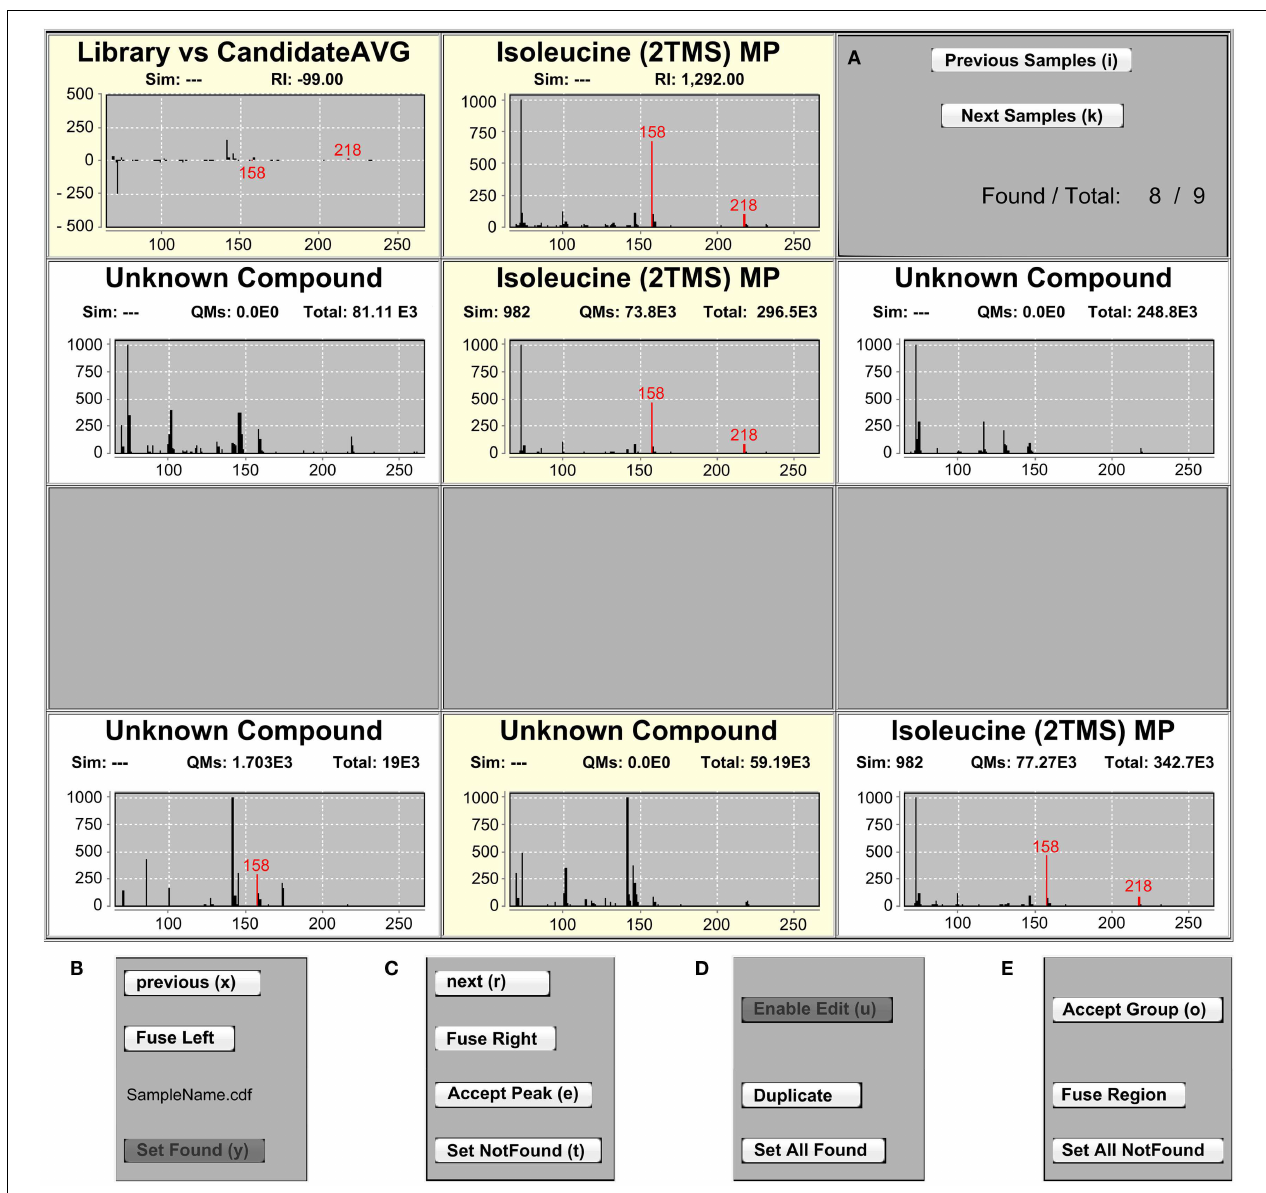
by the “Set NotFound,” and added by the “Set Found” buttons, respectively. Peaks can be fused with their right or left neighbor using the “Fuse Left” and “Fuse Right” buttons in each row. “Accept Peak” leads to the assignment of the library identifier to the currently selected peak and recalculates the similarity score. (D,E) Peaks containing a combined spectrum of co-eluting metabolites can be duplicated with the “Duplicate” button. For convenience, it is possible to add or remove peak assignments to/from all samples at once with the “Set AllFound” and “Set AllNotFound” buttons, as well as to fuse entire regions of peaks with the “Fuse Region” button. Once identifications and alignments are confirmed, “Accept Group” locks the selection from further editing and marks the identifications to be ready for